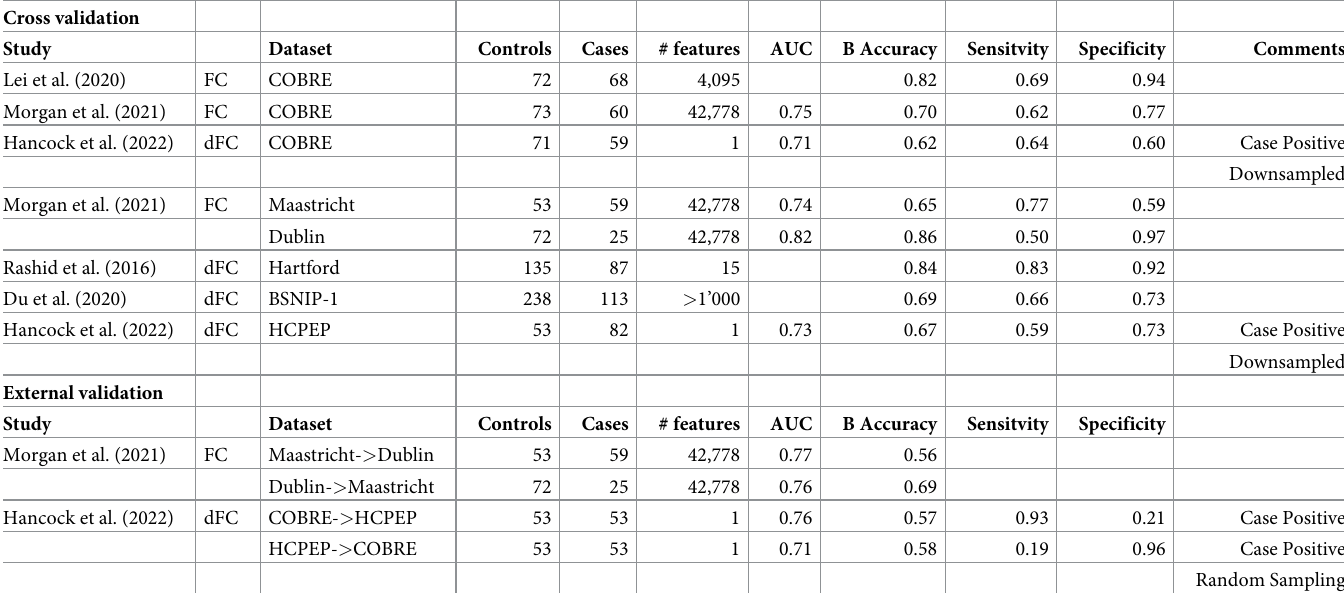
Table 6. Comparison of classifier performance using FC and